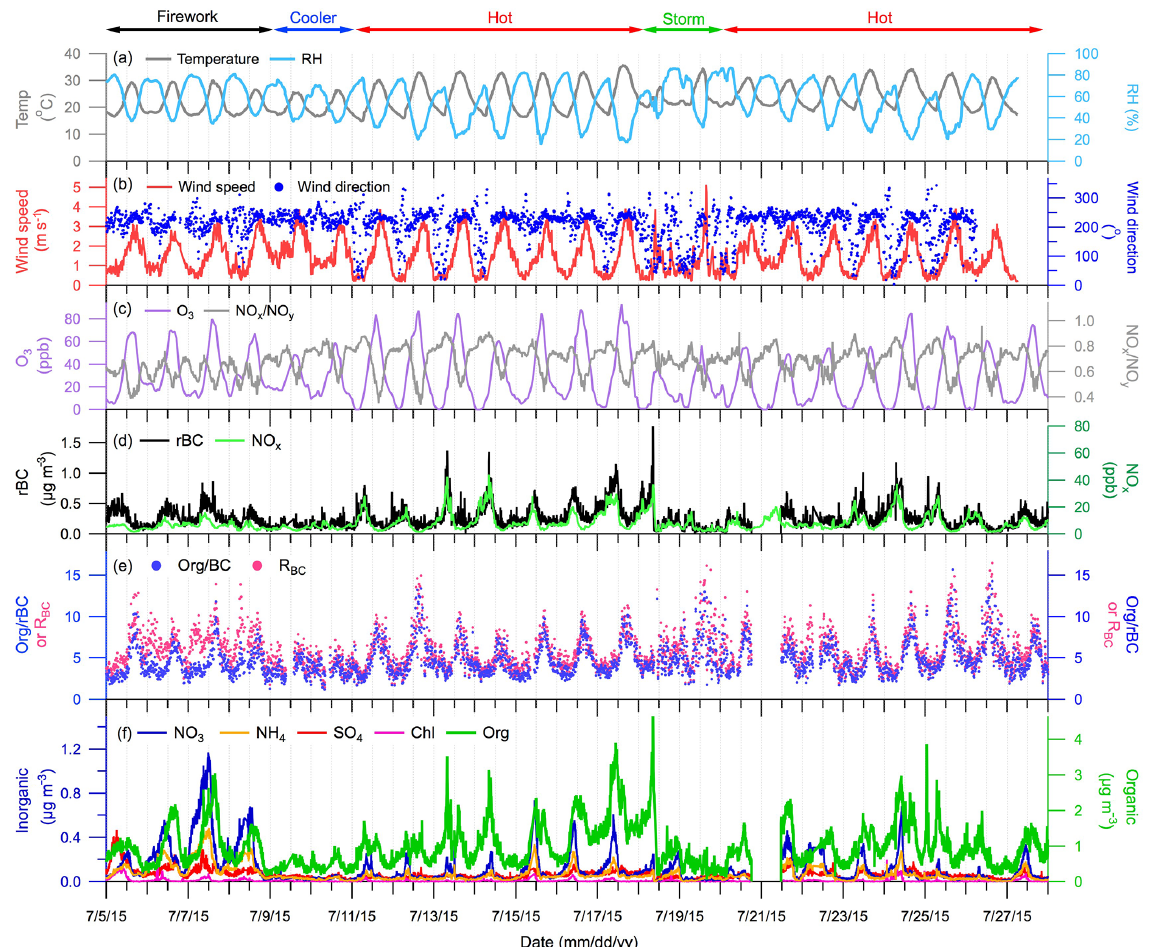
Figure 1. Time series of (a) temperature and RH, (b) wind speed and direction, (c) ozone and NO x / NO y ratio, (d) rBC and NO x , (e) Org / rBC ratio and R BC , and (f) NR-PM rBC (NO 3 : nitrate; NH 4 : ammonium; SO 4 : sulfate; Chl: chloride; and Org: organic).